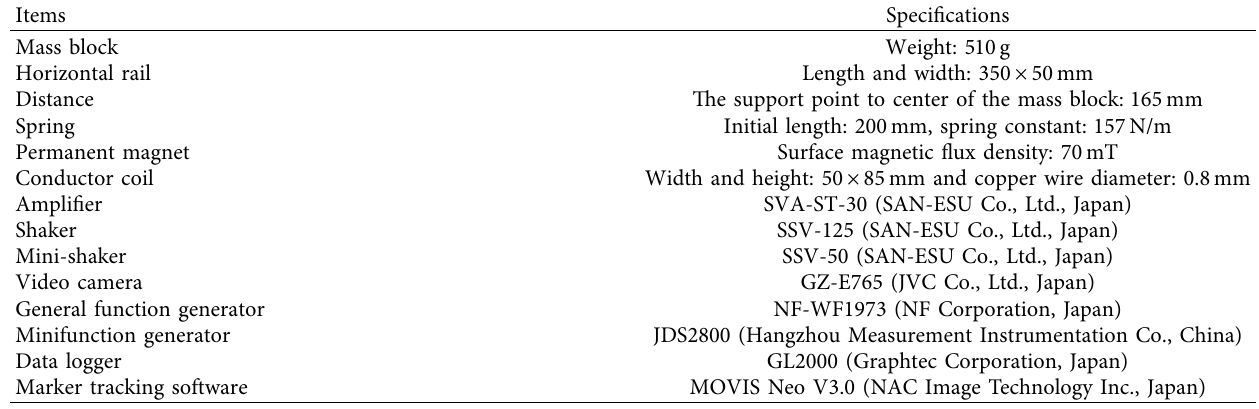
Table 1: Specifications of experimental settings of bistable vibration power generation